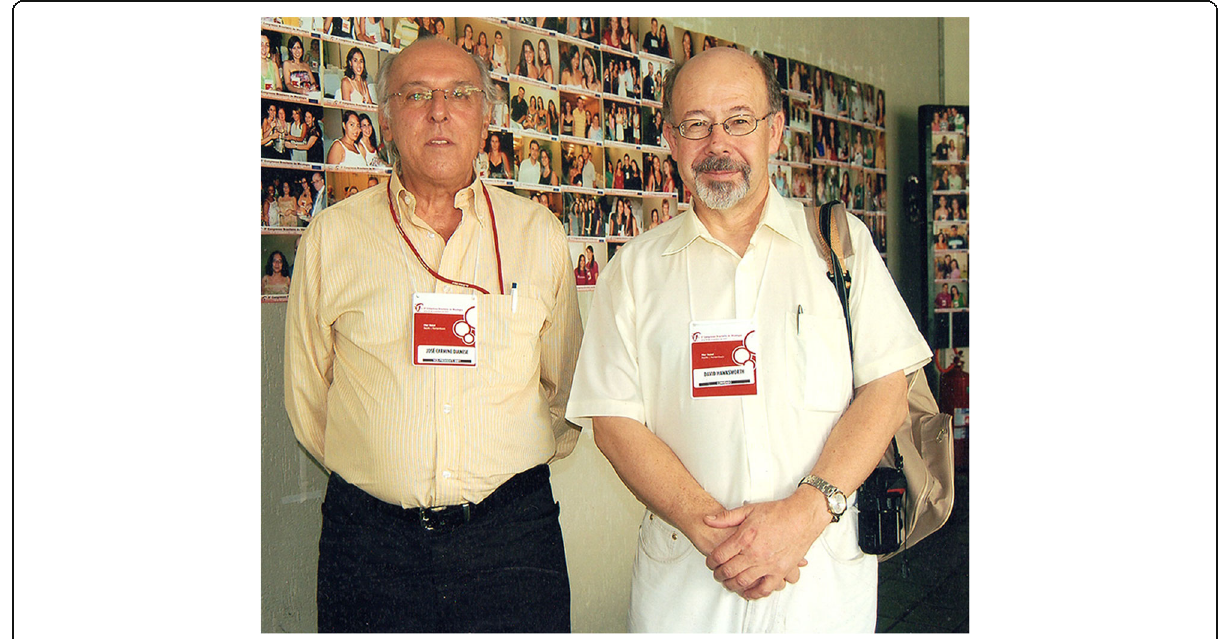
Fig. 24 José Carmine Dianese ( left ) and the author ( right ) at the 5th Congresso Brasiliero de Micologia, Recife,